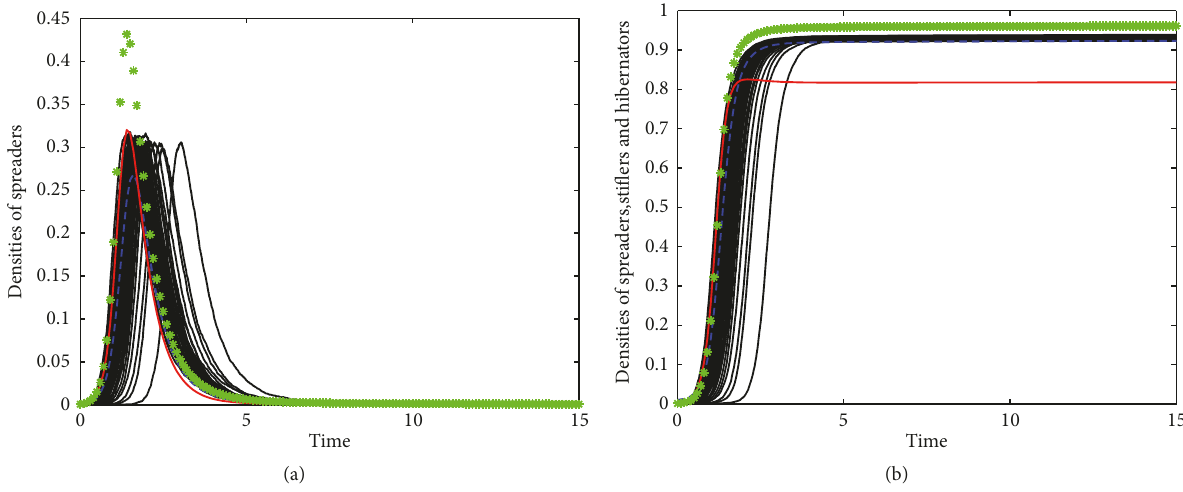
Figure 2: Simulations with 𝜆 = 0.7 , 𝛽 = 0.3 , 𝛼 = 0.2 , 𝛿 = 0.1 , 𝜉 = 0.1 , and 𝜂 = 0.2 . The black lines correspond to 100 Monte Carlo simulations for an SIHR rumor model in a network with the Poisson degree distribution with 𝑘 = 10 . The red solid lines and green star lines represent numerical simulation trajectories based on the mean-field system in [13] and [21], respectively. The blue dashed lines represent numerical simulation trajectories based on system (3). (a) The trajectories of the density of spreaders. (b) The trajectories of the densities of spreaders, stiflers, and hibernators.